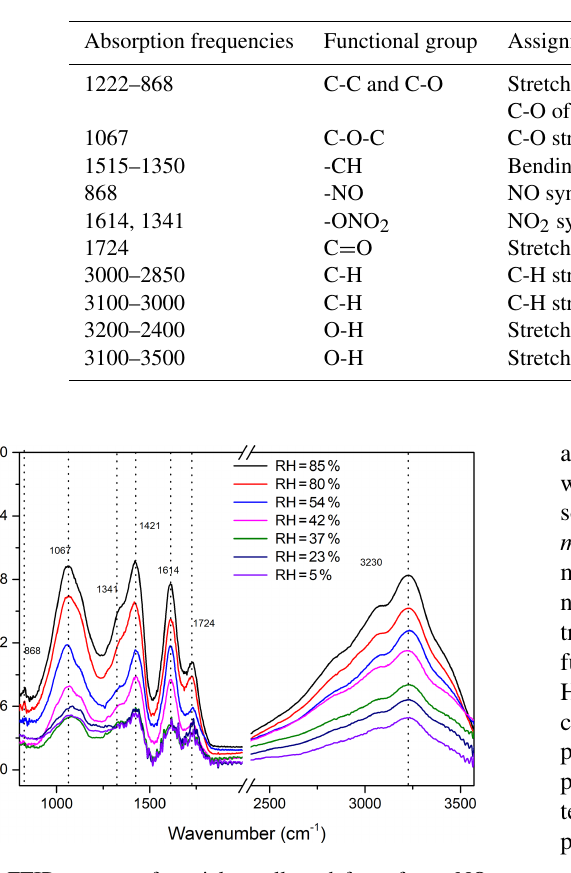
Table 2. Assignment of the observed FTIR absorption frequencies (cm − 1 ).